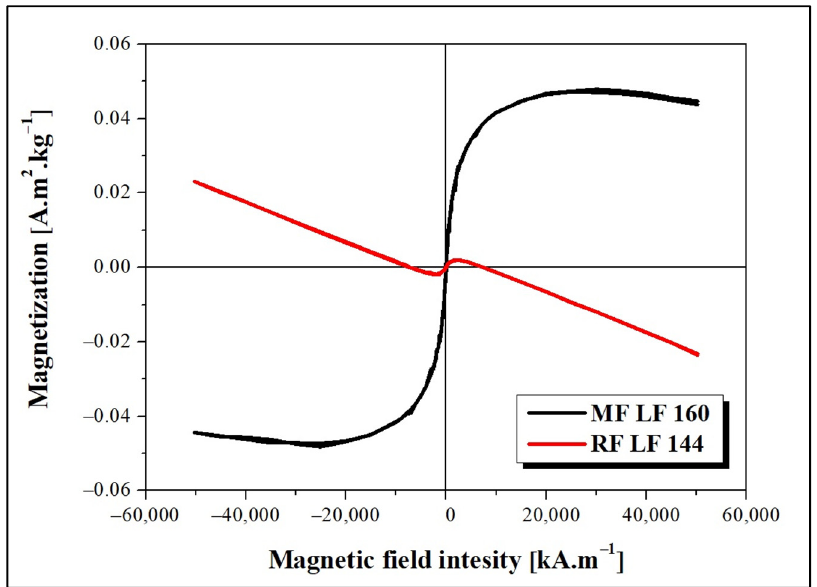
Figure 1. Dependence of magnetization on the magnetic field intensity of magnetoferritin (MF LF 160) and reconstructed ferritin (RF LF 144) at 290 K.